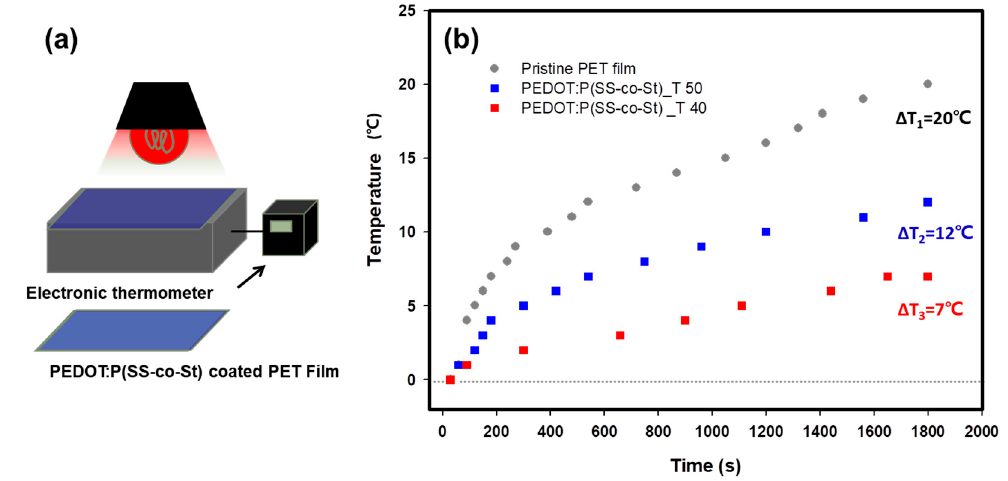
Figure 7. ( a ) Schematic illustration of the thermal insulation experiment, wherein a window in a sealed box was covered with a blank glass slide, commercial PET film, or PEDOT:P(SS-co-St)-coated PET Film. ( b ) Temperature changes of the air inside the box under the PET and PEDOT:P(SS-co-St)-coated PET films.